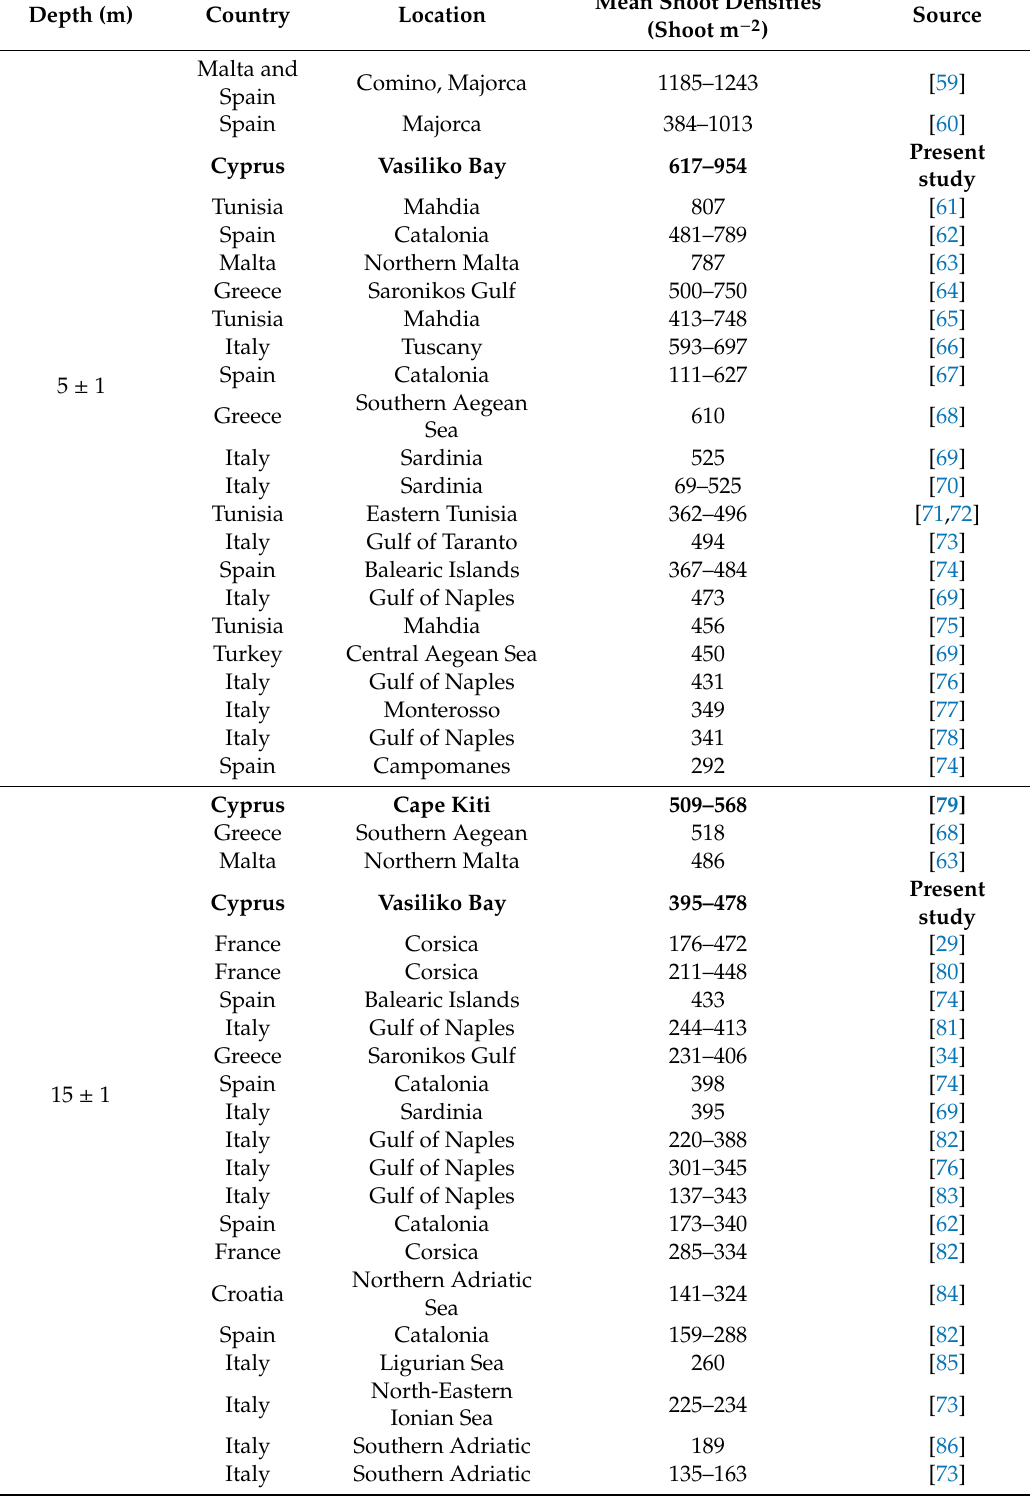
Table 1. Posidonia oceanica shoot density at 5 ± 1 m and 15 ± 1 m depths in Vasiliko Bay (mean range of ten di ff erent sampling stations in each bathymetric zone) and di ff erent Mediterranean sites, ranked by highest mean